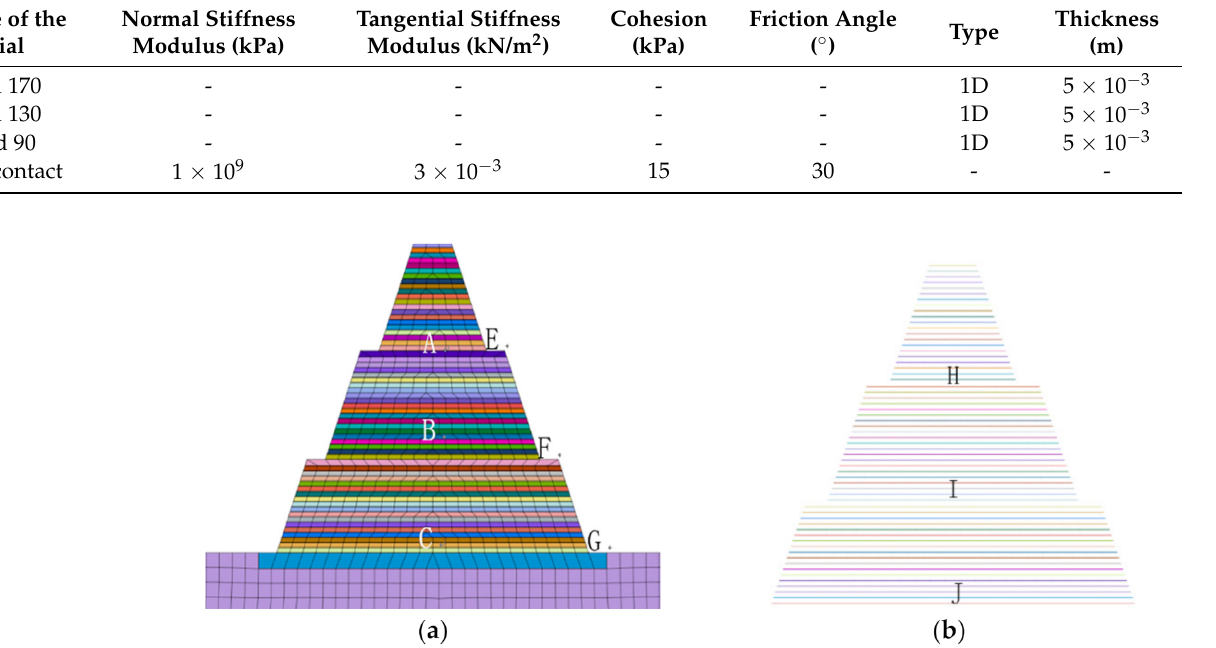
Table 2. Geogrid section and contact characteristic parameter table.